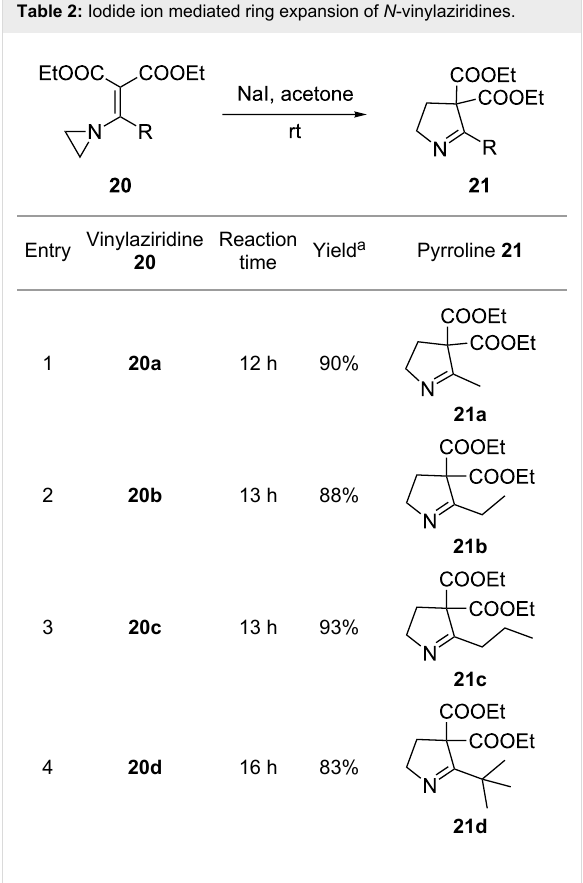
Table 2: Iodide ion mediated ring expansion of N